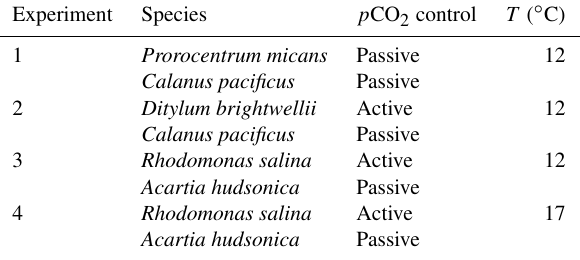
Table 2. Details of recent experiments using the ACCS. Each ex- periment includes an algal prey species (listed first) and a copepod (listed second). Algae were maintained in 1L bottles, about half full and copepods were cultured in 500mL dishes. All cultures were maintained either with semi-continuous culture in atmospheric sim- ulation chambers (passive) or direct bubbling (active). Algal prey cells were added to the copepod cultures twice daily (every 12h) to maintain saturating feeding